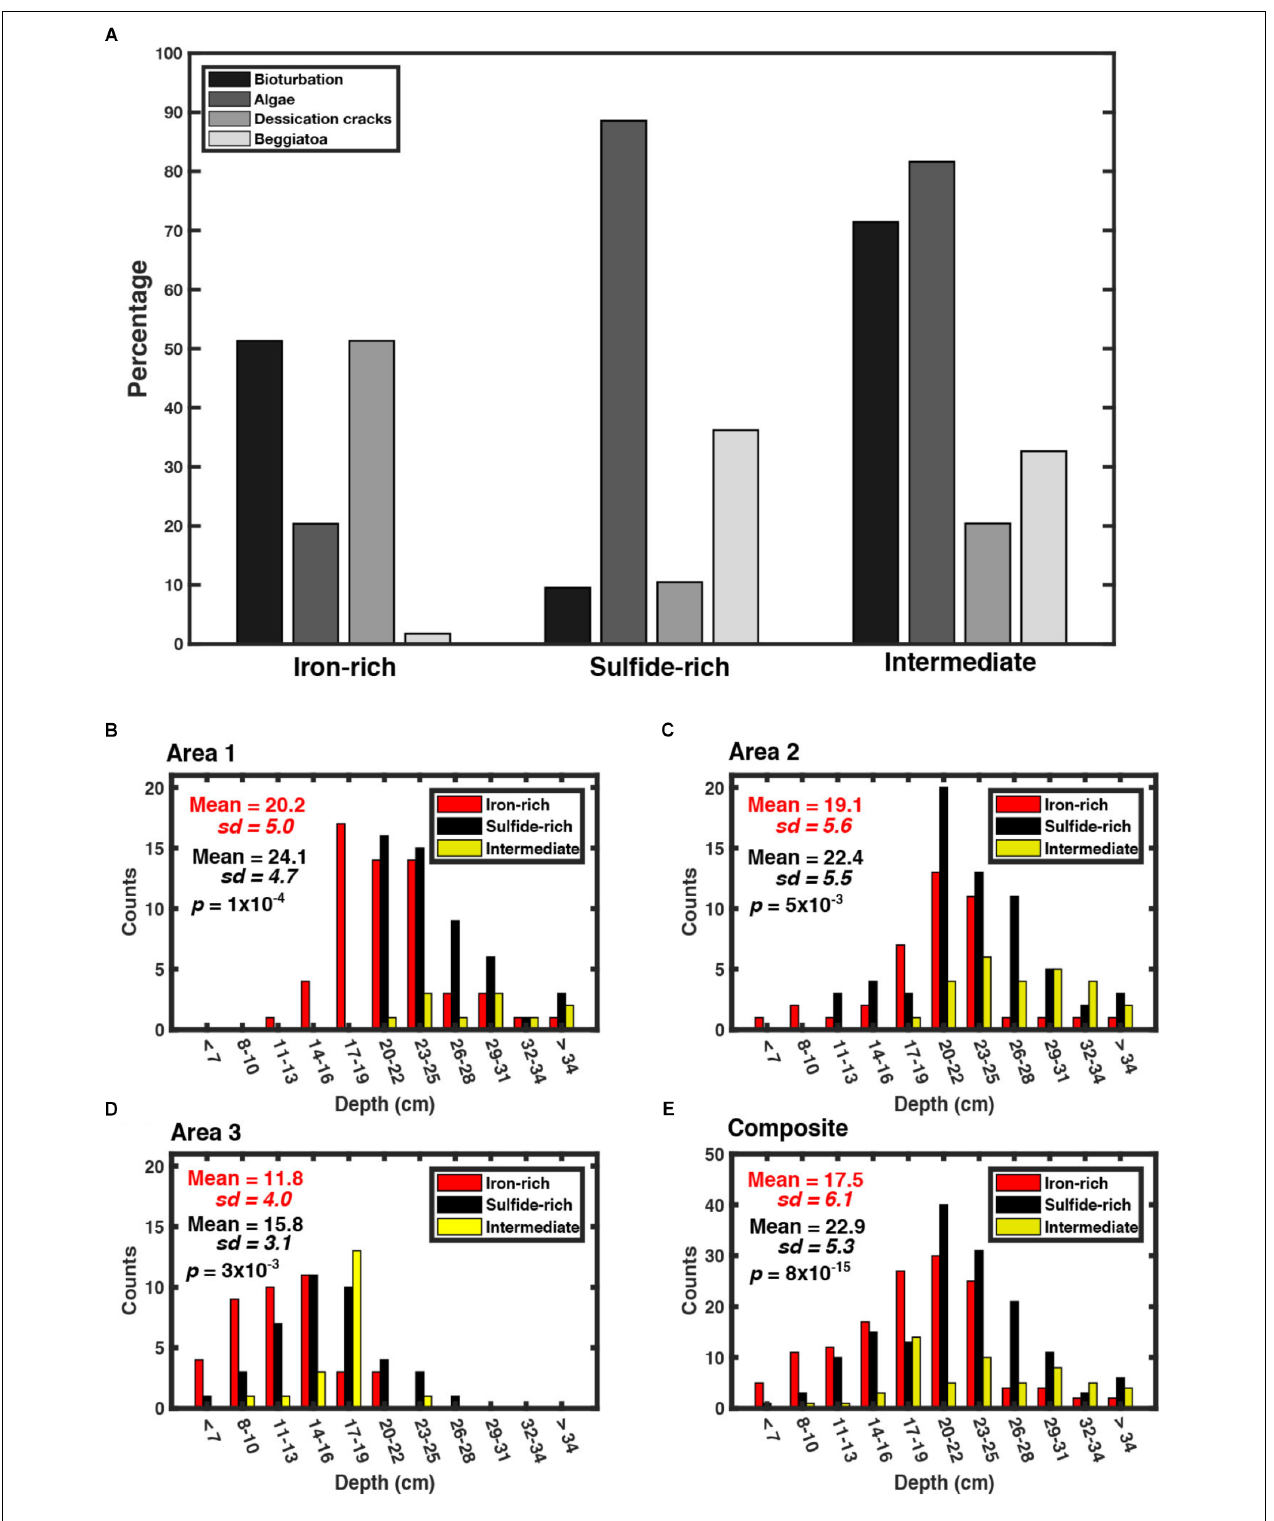
FIGURE 10 | (A) Characteristics [bioturbation, algae, desiccation cracks and sulfide oxidizing bacteria (e.g., Beggiatoaceae )] observed in each category of pond taken in the three areas. (B) Water depth measurements taken in Area 1 for each type of pond (17/05/18). P -value taken from t -tests testing the null hypothesis that there is no difference in water depth between pond classfications. (C) Water depth measurements taken in Area 2 for each type of pond (17/05/18). (D) Water depth measurements taken in Area 3 for each type of pond (19/06/18). (E) Composite made of all depth measurements taken from Area’s 1, 2, and 3.